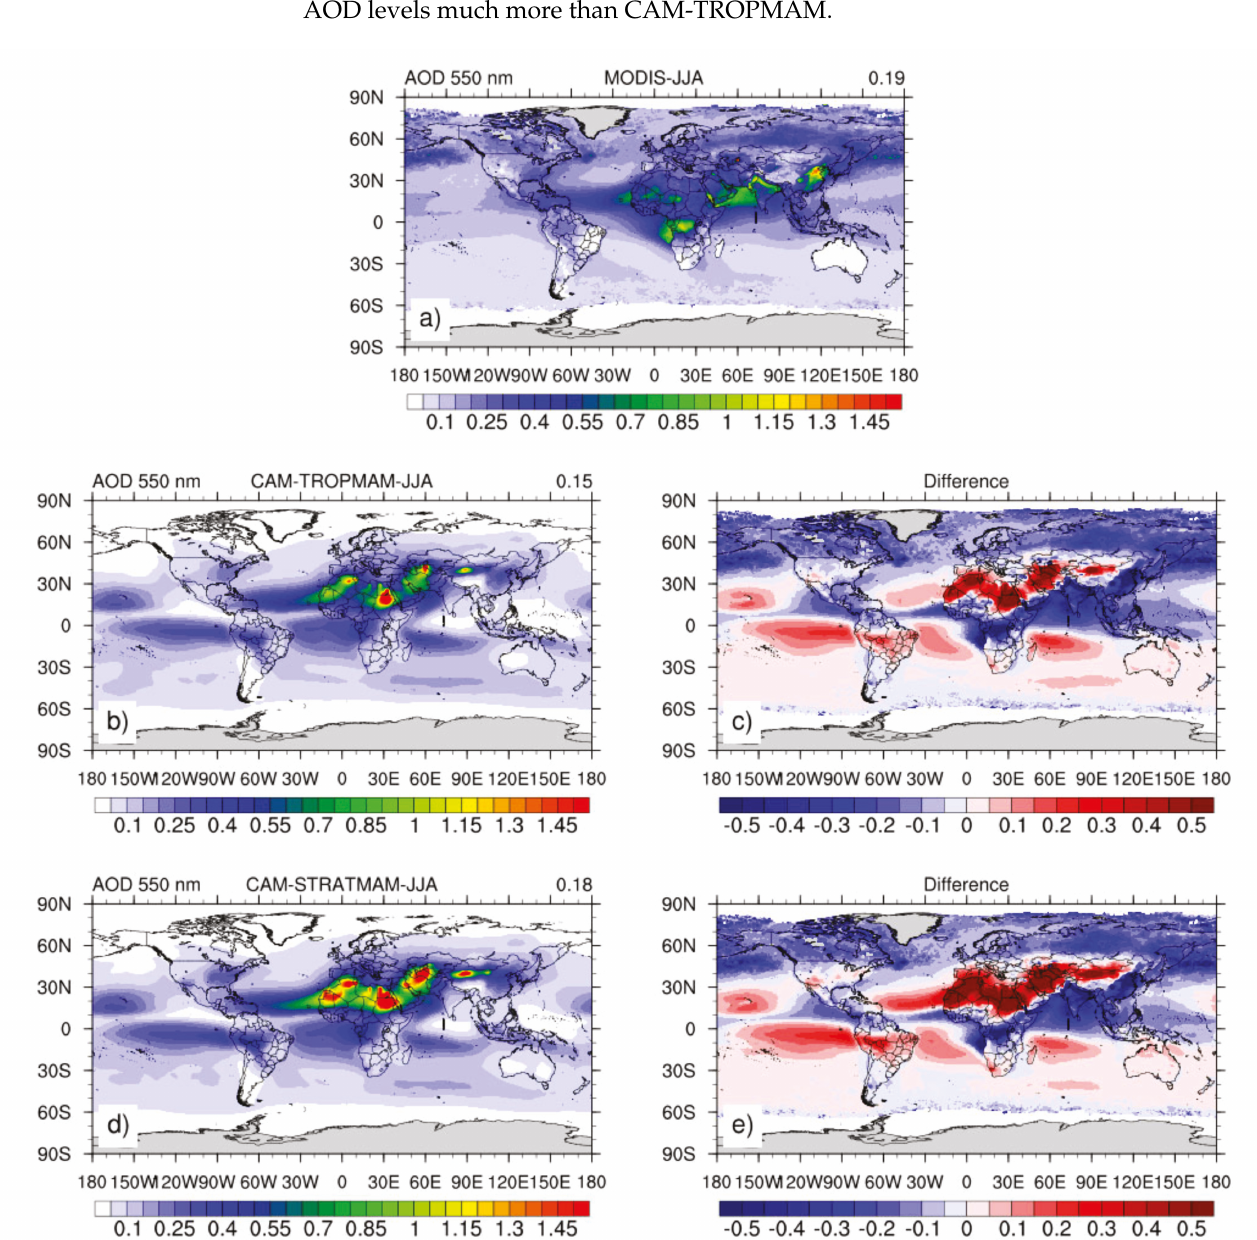
Figure 8. ( a ) AOD observed by MODIS sensor for June-July-August (JJA), in the period of 2010–2014, ( b ) AOD simulated by the CAM5-MAM3 model using tropospheric chemistry and ( d ) tropospheric/stratospheric chemistry mechanisms. The right side of the figure shows the model difference minus the observation (MODIS), ( c ) for tropospheric chemistry and ( e ) for tropospheric/stratospheric